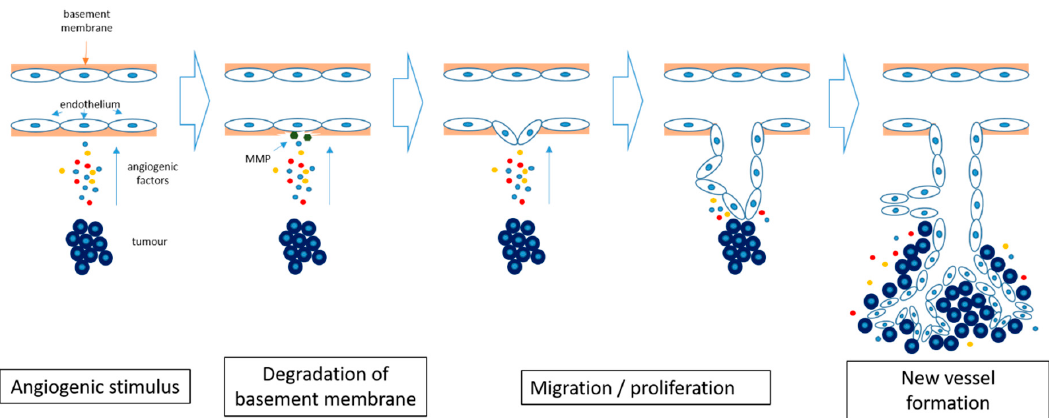
Figure 1. Angiogenesis in cancer. Hypoxia within the tumor induces the release of pro-angiogenic factors and results in degradation of the basement membrane by matrix metalloproteinases (MMP). The endothelial cells start to differentiate and proliferate, forming new blood vessels. The newly formed blood vessels allow further tumor growth.